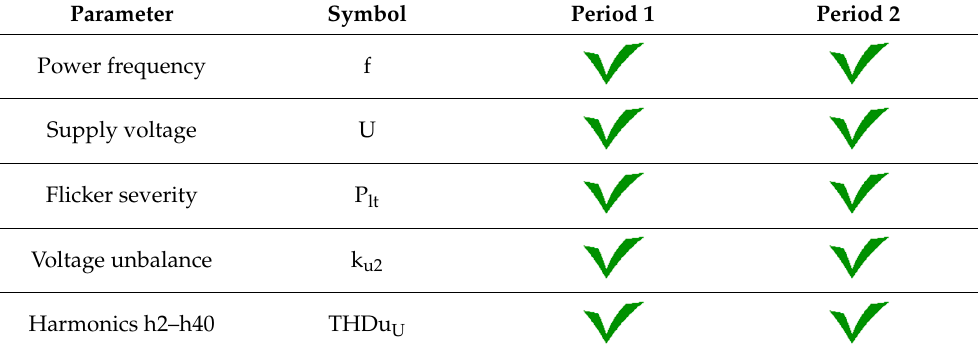
Table 2. Collective statement of achievement or non-achievement of the requirements for a power quality parameter according to EN 50160:2015 standards